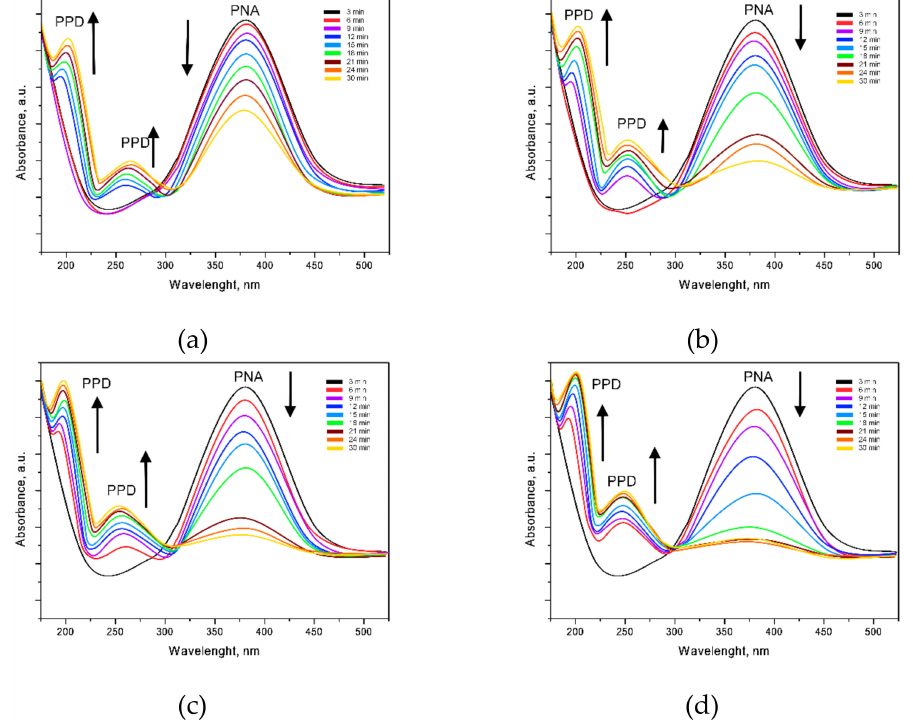
Figure 9. UV–Vis absorption spectra for the reduction of PNA–PPD: ( a ) initial sample; ( b ) irradiated with a dose of 100 kGy; ( c ) irradiated with a dose of 300 kGy; ( d ) irradiated with a dose of 500